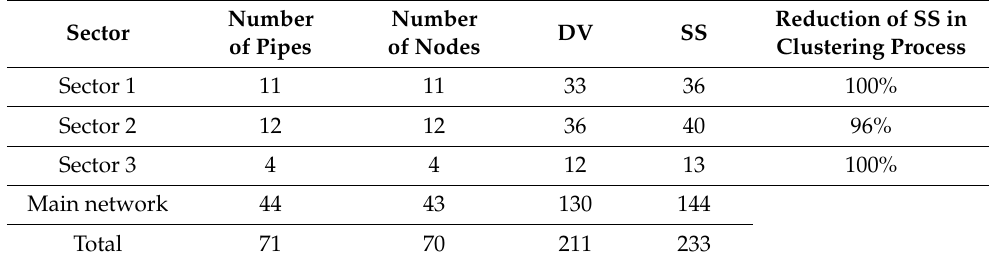
Table 1. Elements, magnitude of SS and percentage of reduction of the sectors that make up the Balloon